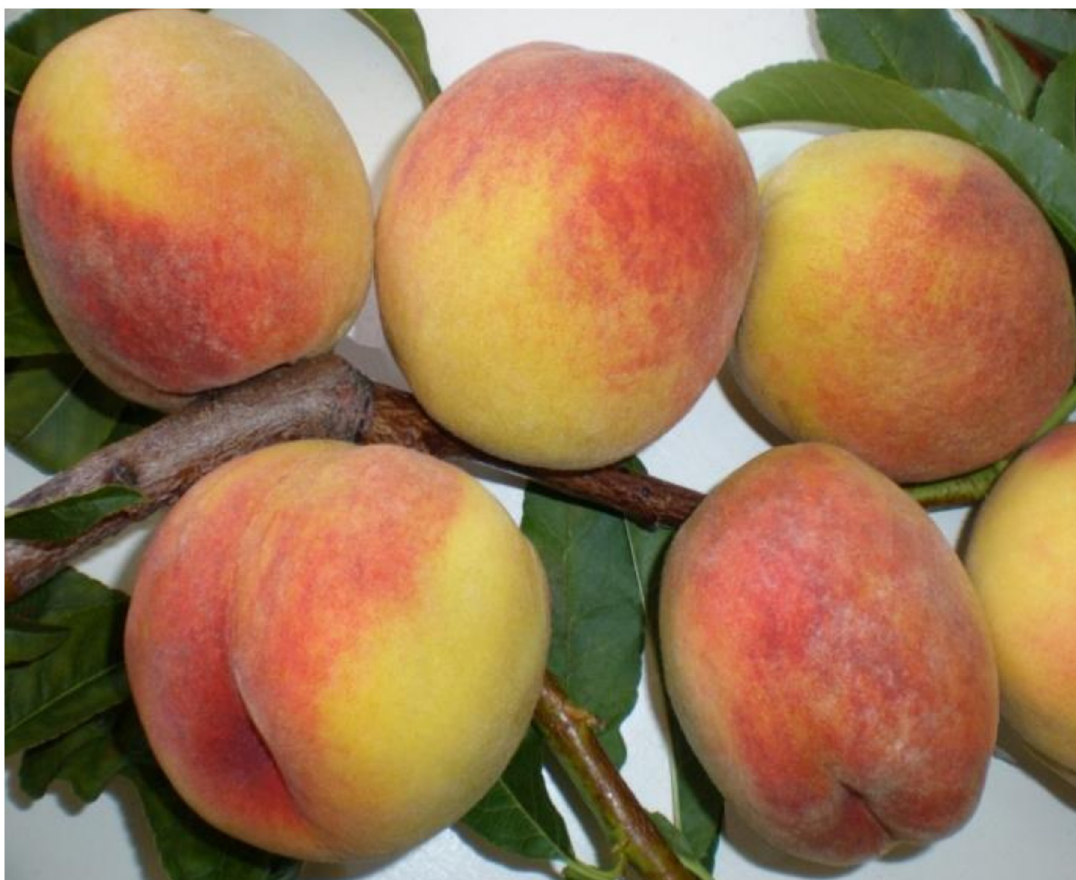
Fig 1. A photo of a peach fruit of P . persica cv. ‘Sovetskiy’. Photo by A.